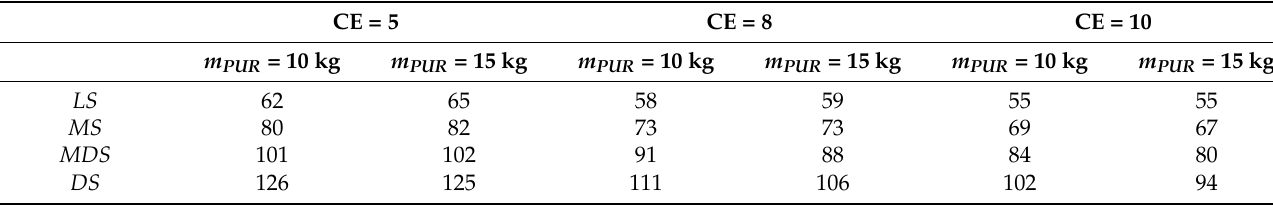
Table 3. Values of G (MPa) for composite